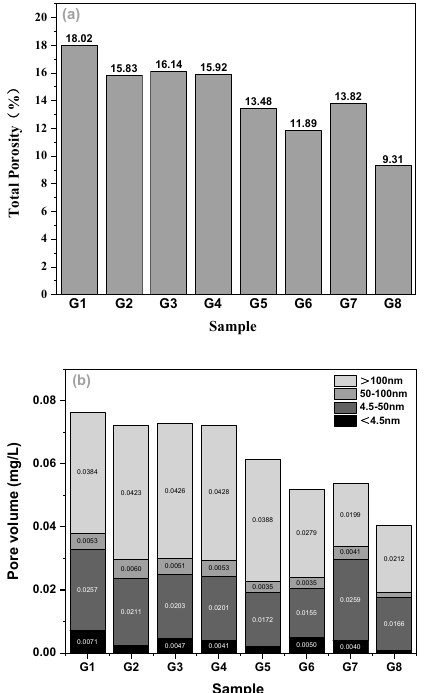
Figure 9. Total porosity ( a ) and absolute pore volume ( b ) of concrete.